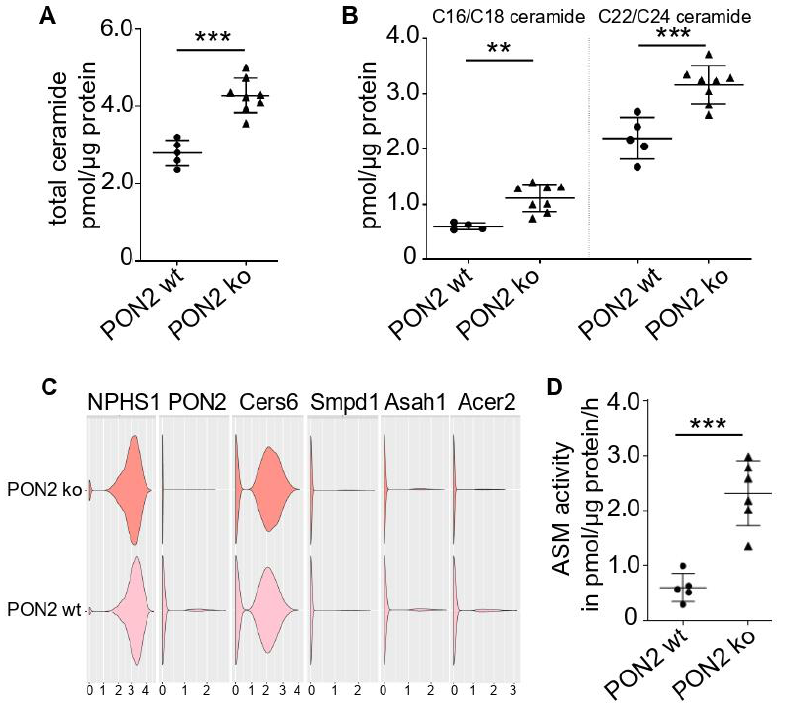
Figure 3. PON2 deficiency alters lipid composition in adriamycin-induced nephropathy kidney cortex samples of adriamycin-treated mice were subjected to LC MS/MS to quantify ceramide content and subclasses. ( A ) Total ceramide content is significantly increased in PON2 ko (triangles) as compared to wildtype mice (dots) ( n = 8 and 5, respectively). ( B ) Both C16/C18 ceramide and C22/C24 ceramide are increased in PON2 ko compared to control. ( C ) Expression profiling of PON2-proficient and -deficient podocytes investigating RNA levels of NPHS1, ceramide generating enzymes Cers6 and SMPD1/2, and ceramidase enzymes Asah1 and Acer2. ( D ) Acid sphingomyelinase (ASM) activity was assessed in cortex samples of PON2 ko and wildtype mice. ASM activity is largely increased in PON2 ko vs. PON2 wt ( n = 6 and 5, respectively) (** p < 0.01; *** p < 0.001).